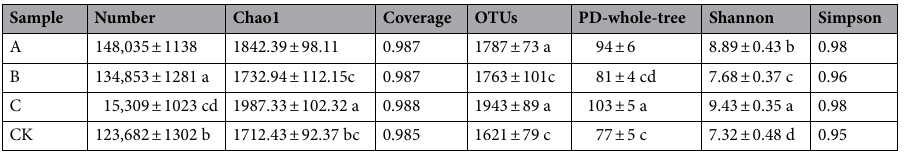
Table 4. Effect of different treatments on the α diversity of bacterial community.